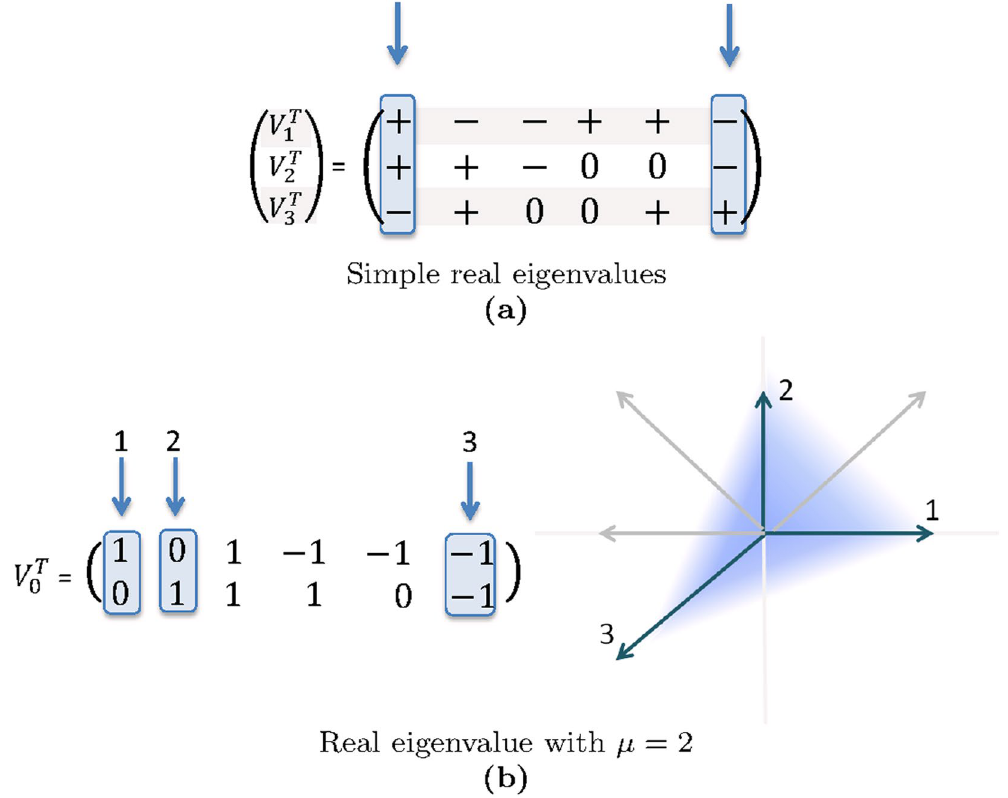
Figure 1. Constructing a minimal set of unilateral control inputs. ( a ) When the real eigenvalues of A are simple, condition ( ii ) of Theorem 1 leads to a set cover problem: Each control input “covers” the row-vectors V iT either positively or negatively or not at all. A minimal set of control inputs should be constructed such that all vectors are covered both positively and negatively. The two highlighted columns form a set cover solution and correspond to = B e e [ ] 1 6 . ( b ) Consider the eigenspace of a real eigenvalue of geometric multiplicity μ = 2. The controllability condition is then a problem of positively spanning sets. The three highlighted columns correspond to = B e e e [ ] 1 2 6 and they positively span  2